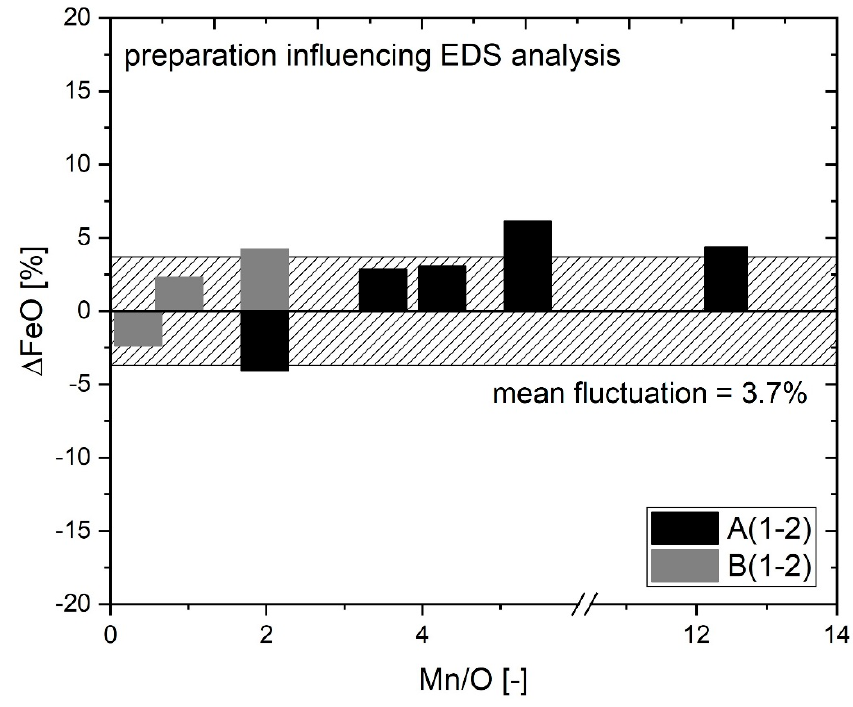
Figure 7. EDS data evaluation for A(1-2) and B(1-2).